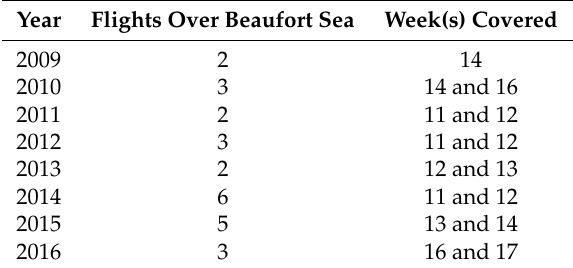
Table 2. Weeks of IceBridge data for years